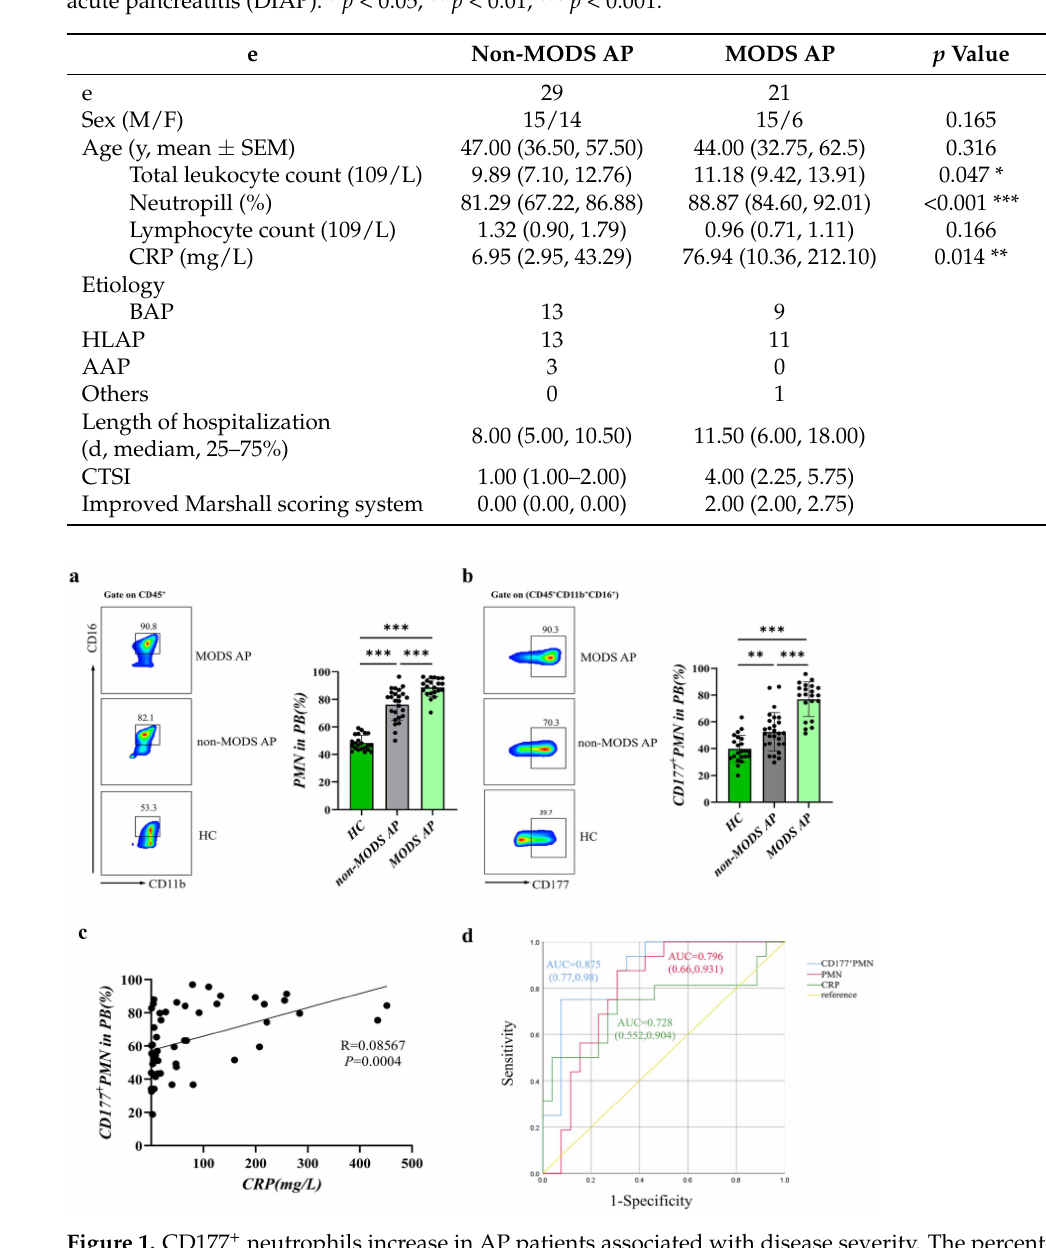
Figure 1. CD177 + neutrophils increase in AP patients associated with disease severity. The percent- ages of neutrophils (CD45 + CD11b + CD16 + ) ( a ) and CD177 + neutrophils (CD45 + CD11b + CD16 + CD177 + ) ( b ) in peripheral blood (PB) from AP patients and HCs were analyzed by flow cytometry. ( c ) CD177 + PMNs in AP patients showed a positive correlation with the levels of CRP. ( d ) ROC curve analysis of CD177 + PMNs, PMNs, and CRP levels for diagnosing MODS. Black dots represent samples. Statistical significance is indicated by ** p < 0.01, *** p < 0.001. AP, acute pancreatitis; PB, peripheral blood; PMNs, polymorphonuclear leukocytes; ROC, receiver operating characteristic; CRP, C-reactive protein; AUC, area under curve; MODS, multiple organ dysfunction